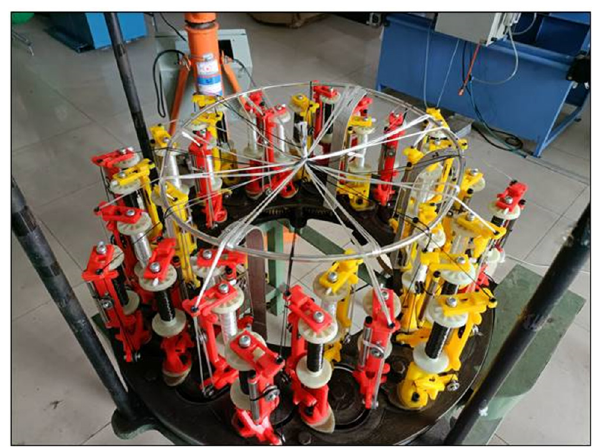
Figure 3: Two - dimensional braiding machine with 32